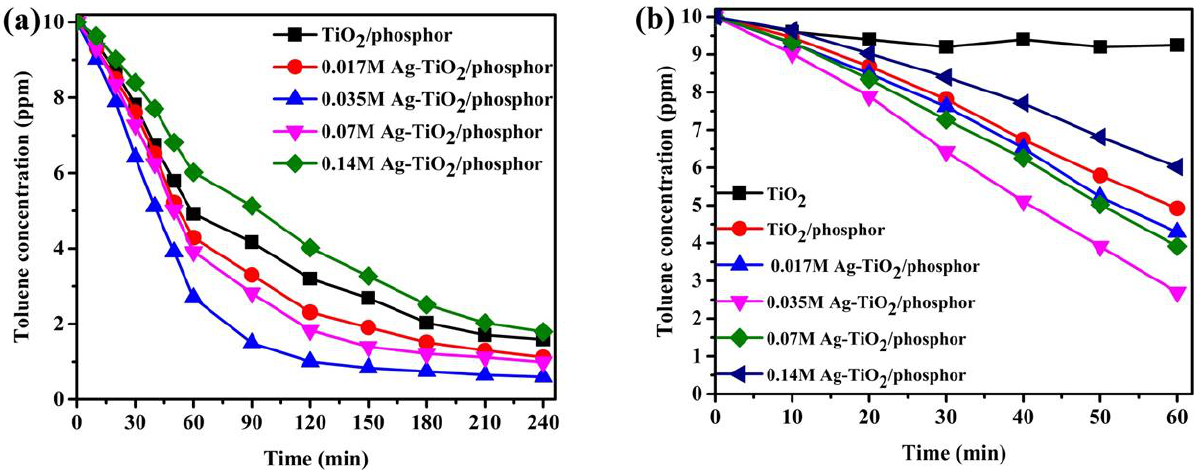
Figure 8. Photocatalytic degradation of toluene over Ag-TiO 2 /Sr 4 Al 14 O 25 :Eu 2+ ,Dy 3+ photocatalyst/phosphor beads under visible light irradiation.